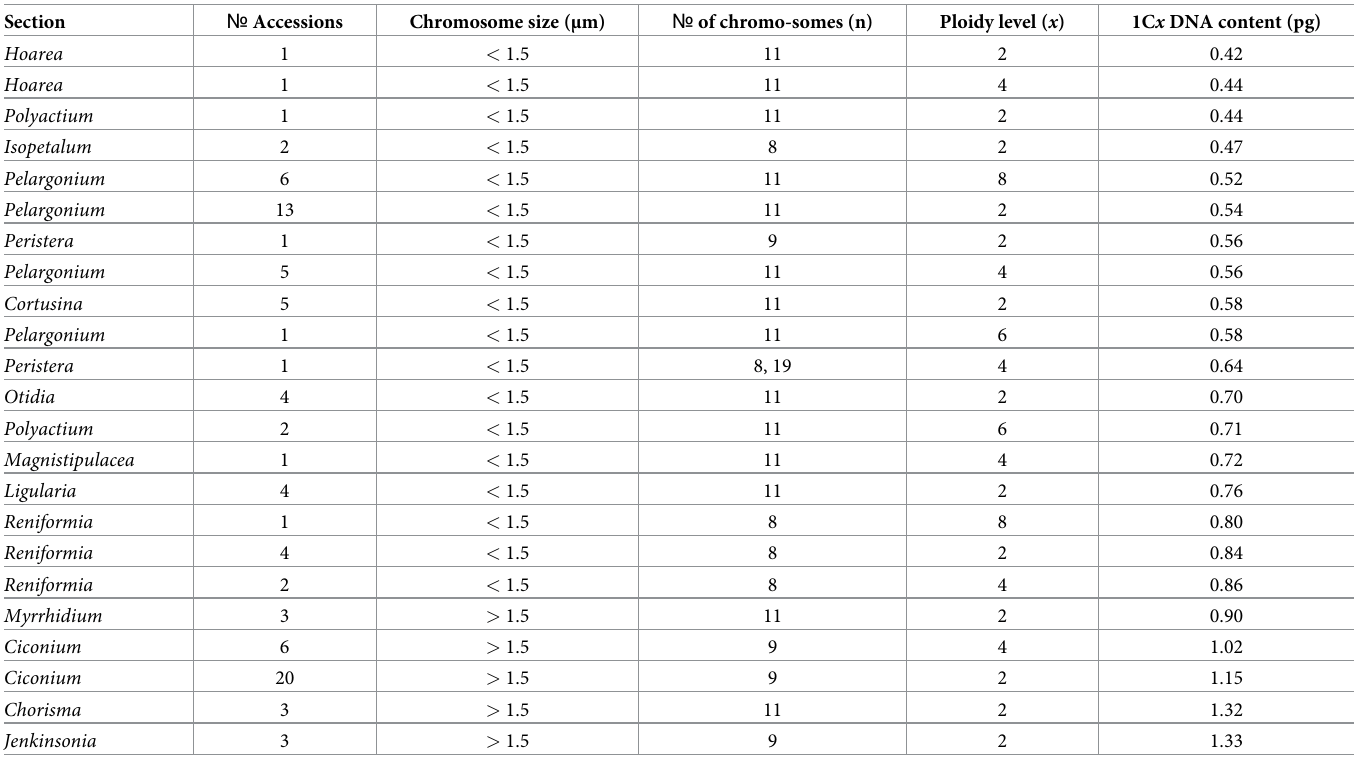
Table 4. Summary of the 1C x DNA contents of the analyzed Pelargonium sections regarding chromosome size, basic chromosome number and ploidy